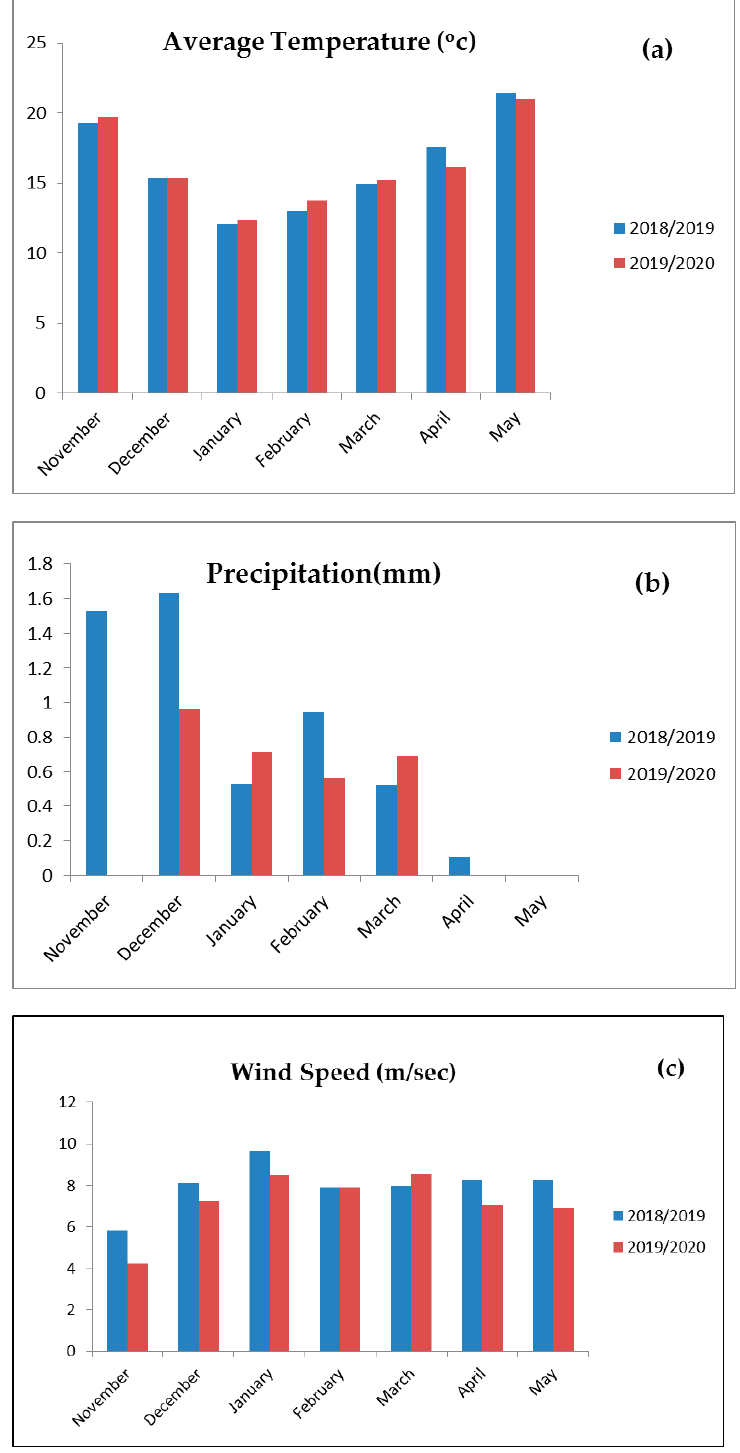
Figure 1. ( a ). Average monthly temperature (°C), ( b ). total monthly precipitation (mm) and ( c ). average monthly wind speed (m/sec) for the two winter seasons.